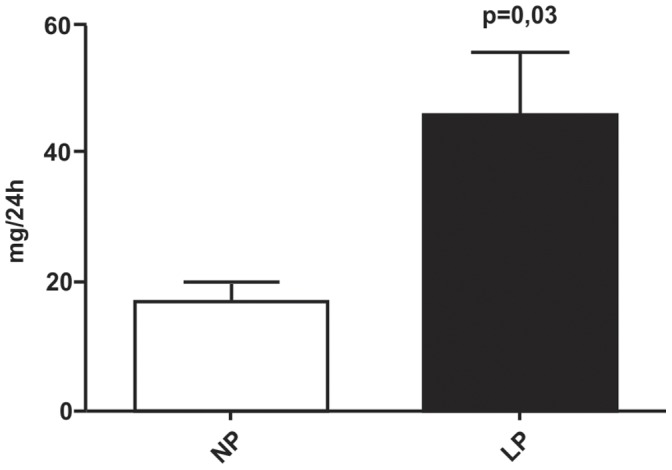
Daily urinary protein excretion in 16-wk-old LP offspring (n = 10) compared to appropriated age-matched controls (n = 10).